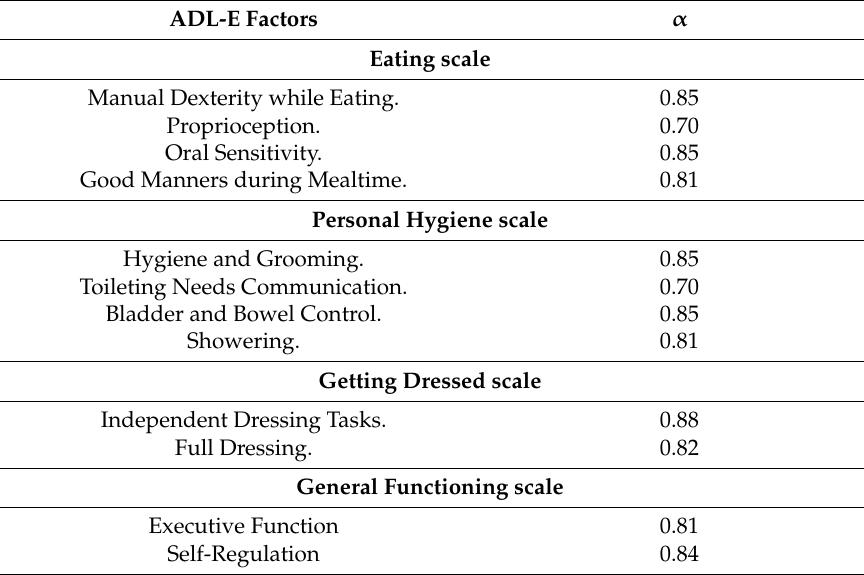
Table 14. Internal consistency of the